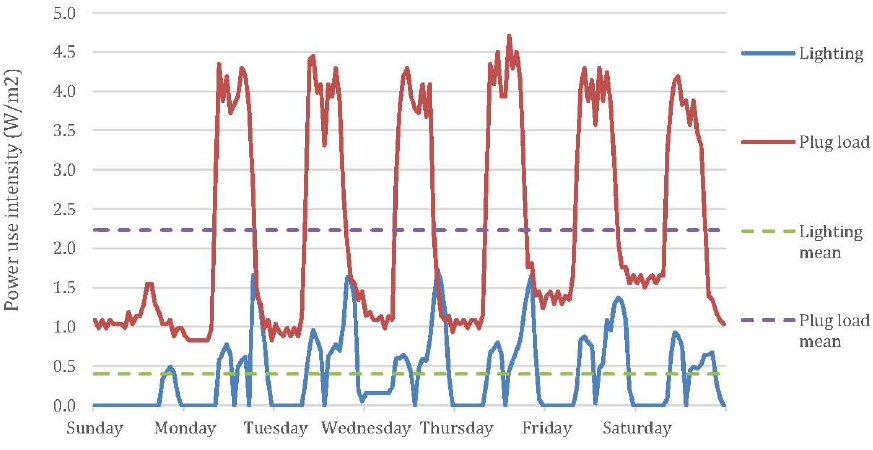
Figure 9. Power Use Intensity for Plug Loads ( red ) and Lights ( blue ) for one week (1–7 August 2011) from the 8th floor offices of the IBR